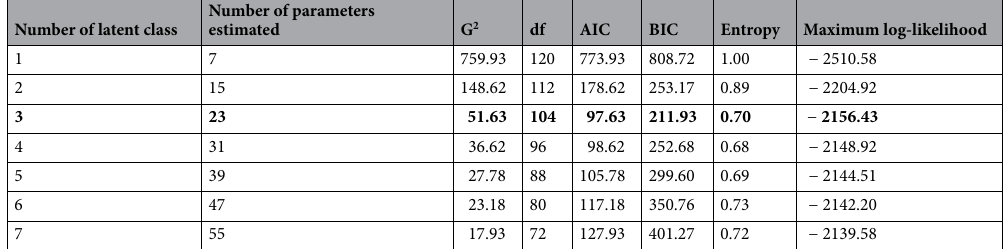
Table 1. Comparison of LCA models with different latent classes based on model selection statistics. The final model is in bold. LCA, latent class analysis; AIC, Akaike information criterion; BIC, Bayesian information